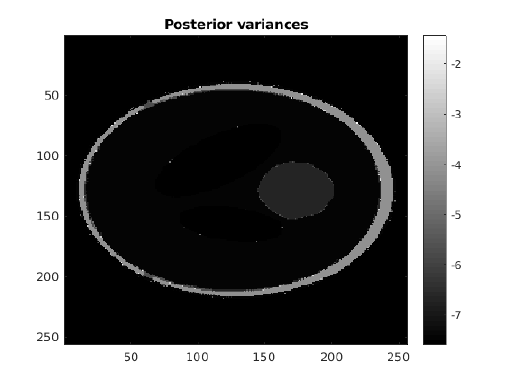
Figure 6. Variances (log) obtained by VBA